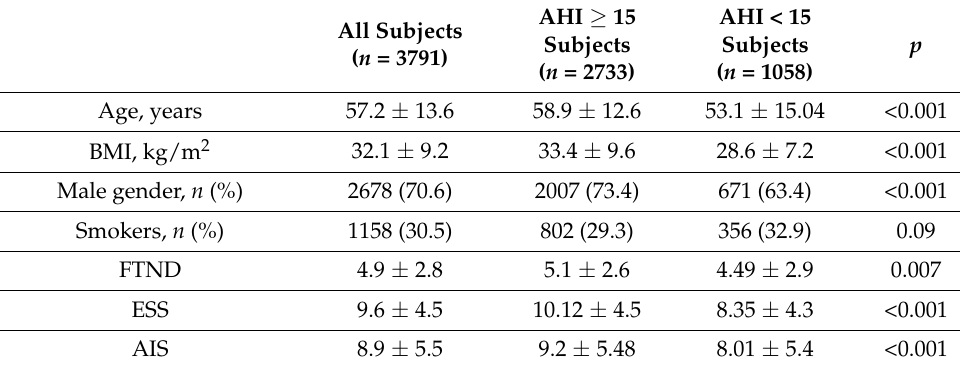
Table 1. Clinical characteristics of the population and comparison between subjects with AHI ≥ 15 vs. AHI <